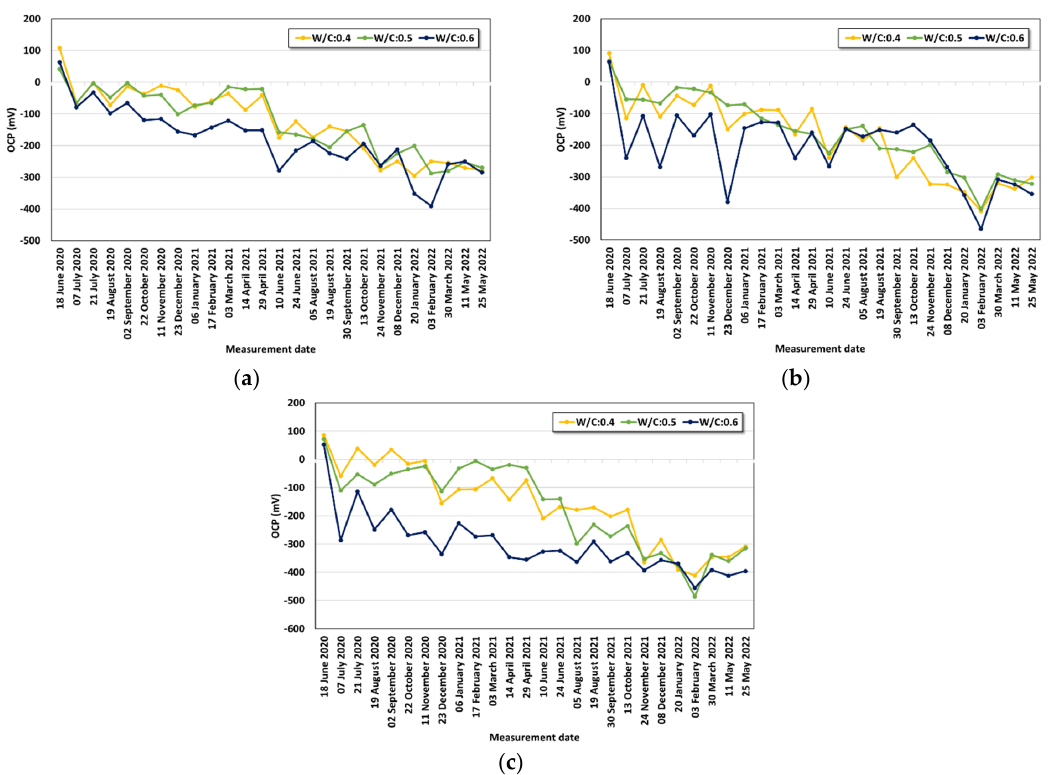
Figure 8. Open-circuit potential (OCP) evaluation under 3.5% chloride exposure conditions. Cover depths: ( a ) 60 mm, ( b ) 45 mm, and ( c ) 30